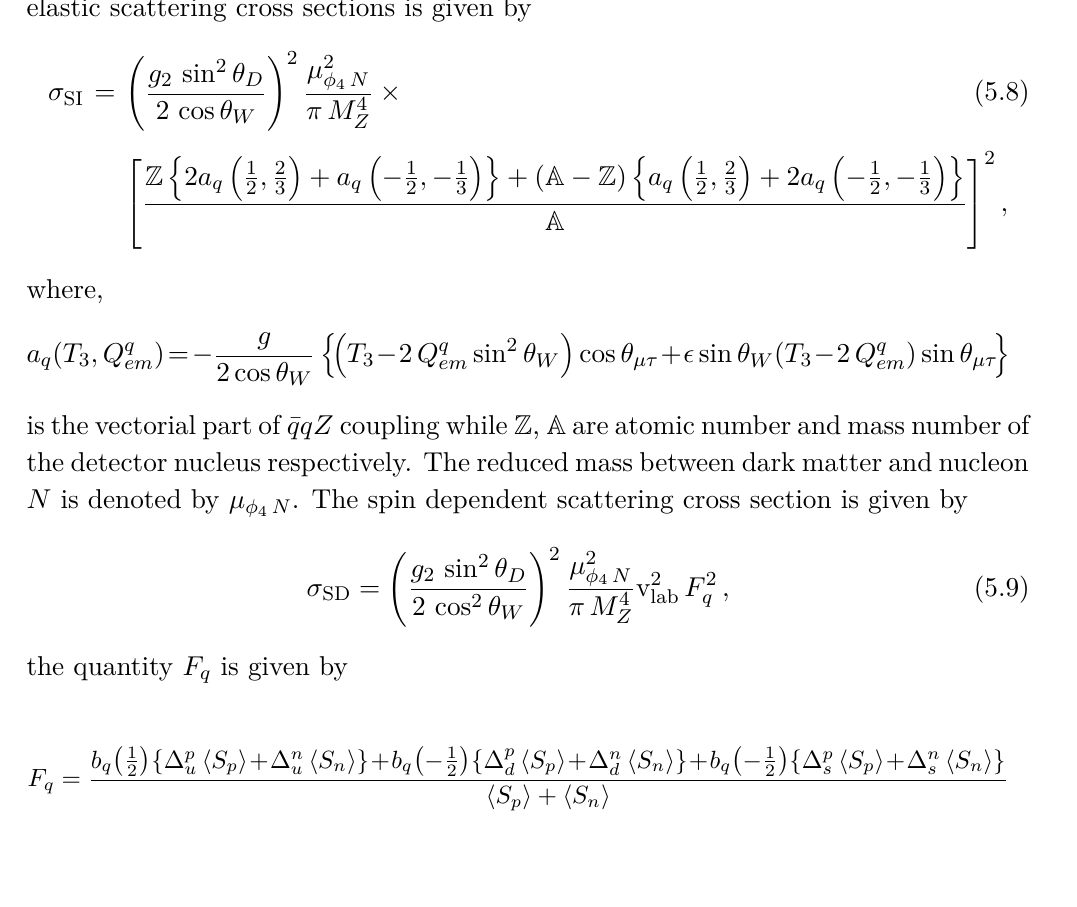
are same as those for φ φ † → φ † φ † 4 4 4 4